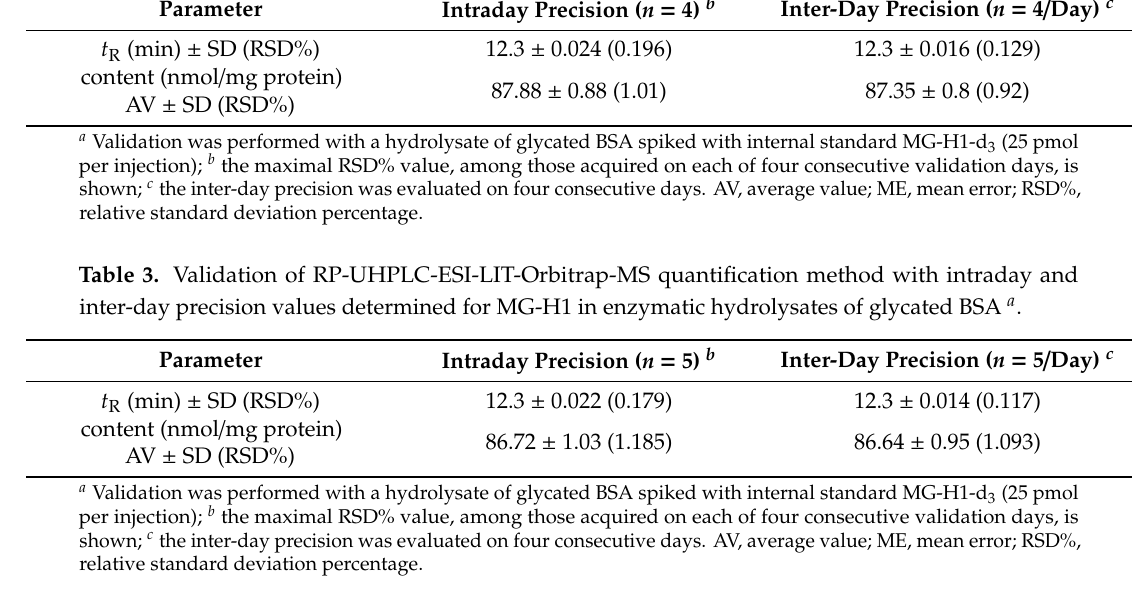
Table 4. Validation of the sample preparation procedure (enzymatic hydrolysis with subsequent solid phase extraction) with intraday and inter-day precision values determined for MG-H1 in enzymatic hydrolysates of seed protein extract a